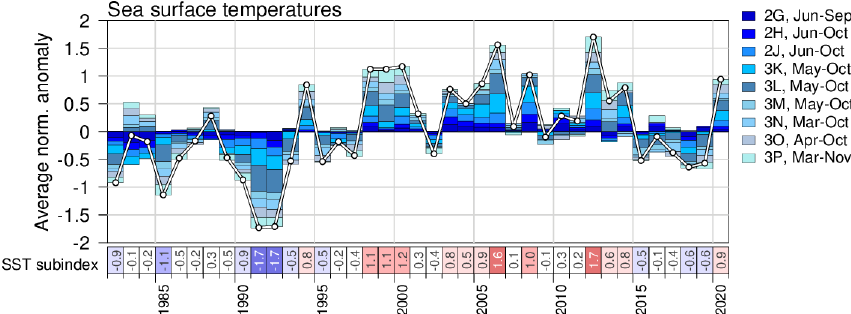
Figure A4. Same as Fig. 6 but using a climatology referenced to the 1981–2010 period.